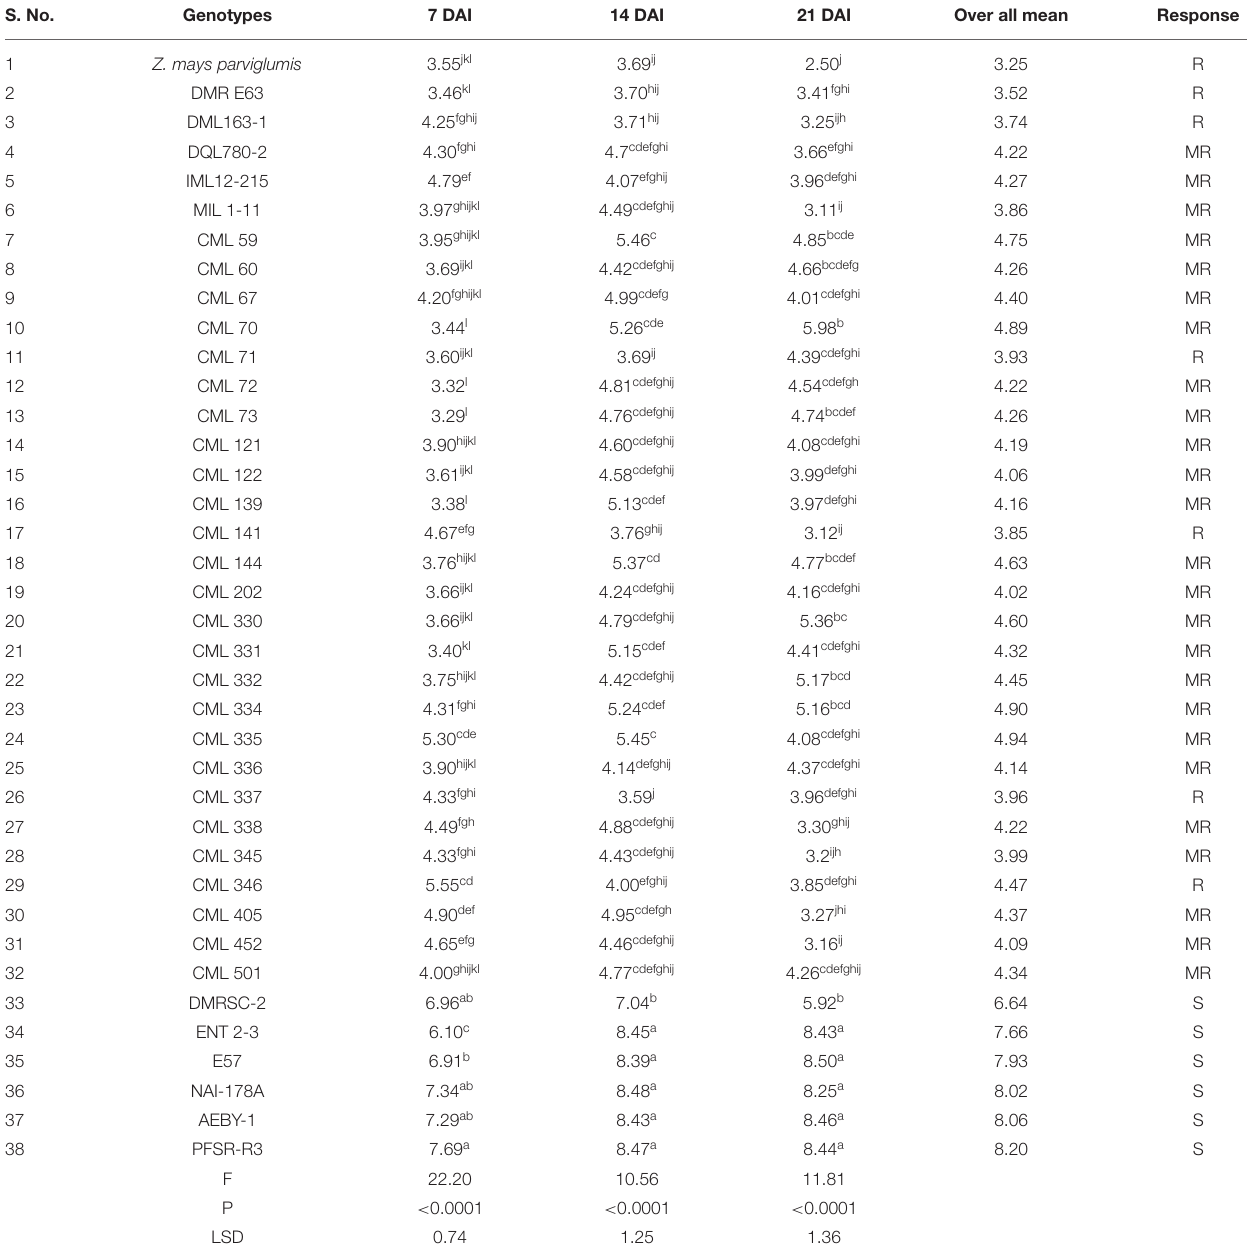
TABLE 5 | Leaf damage rating of maize germplasm on different days after infestation (DAI) in net house conditions. S.